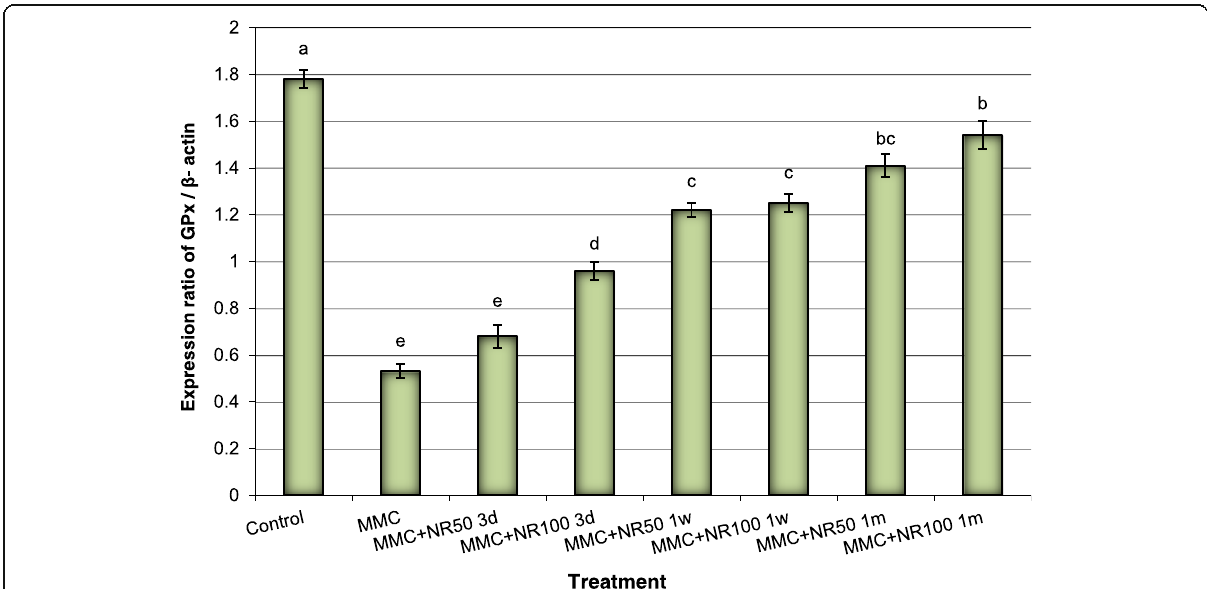
Fig. 2 Expression alteration of GPx gene in liver tissues collected from MMC-treated mice supplemented with different doses (50 and 100 mg/kg body wt) of Nitraria retusa leaf extracts at different time intervals (3 days, 1 week, and 1 month). Data are presented as mean ± SEM. a,b,c,d Mean values within tissue with unlike superscript letters were significantly different ( a P < 0.01, b,c,d P <